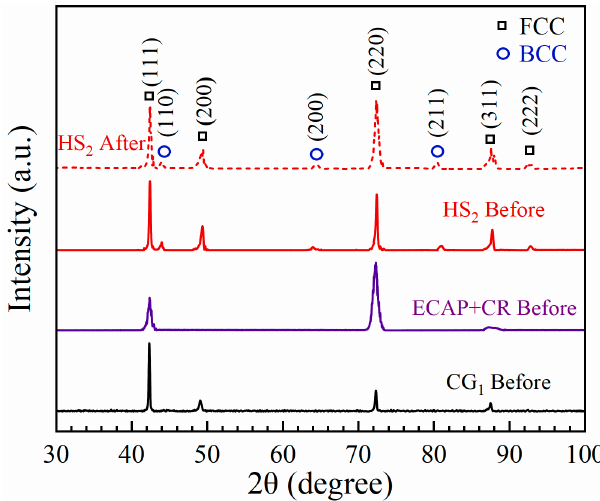
Figure 6. The XRD spectra for various samples prior to and after tensile testing.